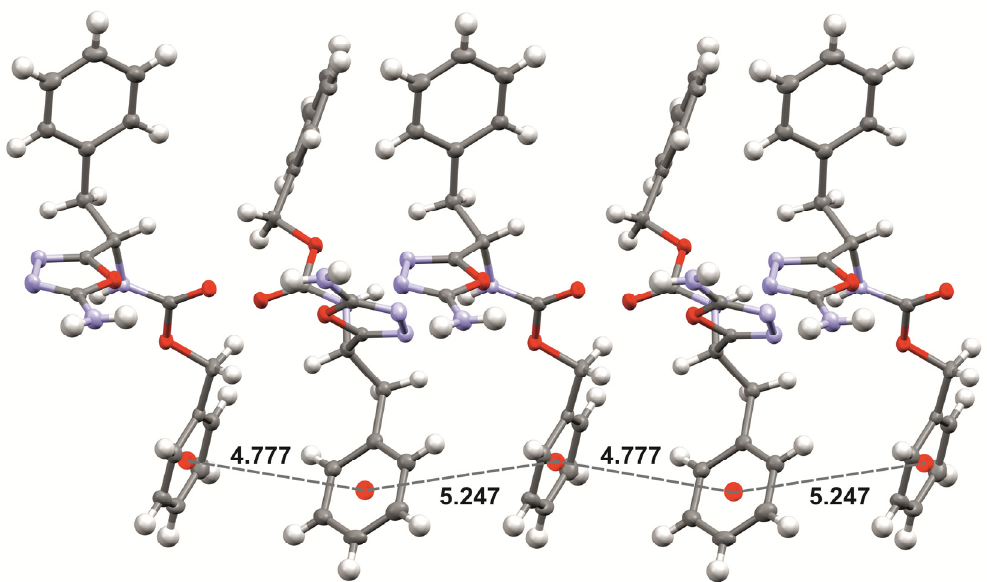
Figure 4. Aromatic interactions in the crystal packing of 2 illustrated by centroid-centroid distances in